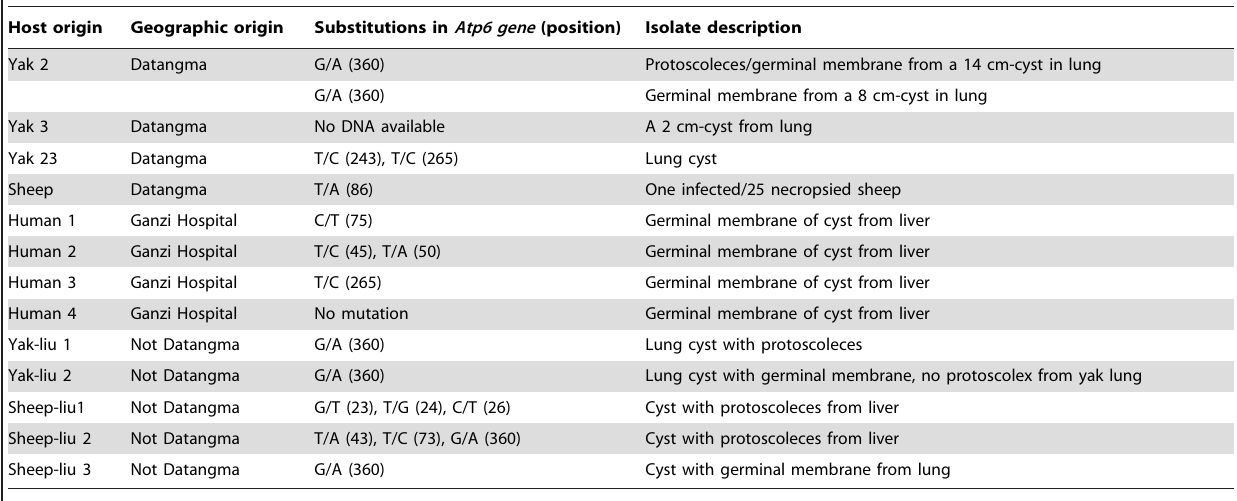
Table 4. Substitutions in the atp6 gene of the E. granulosus common sheep/dog strain (G1 genotype) isolates investigated in this